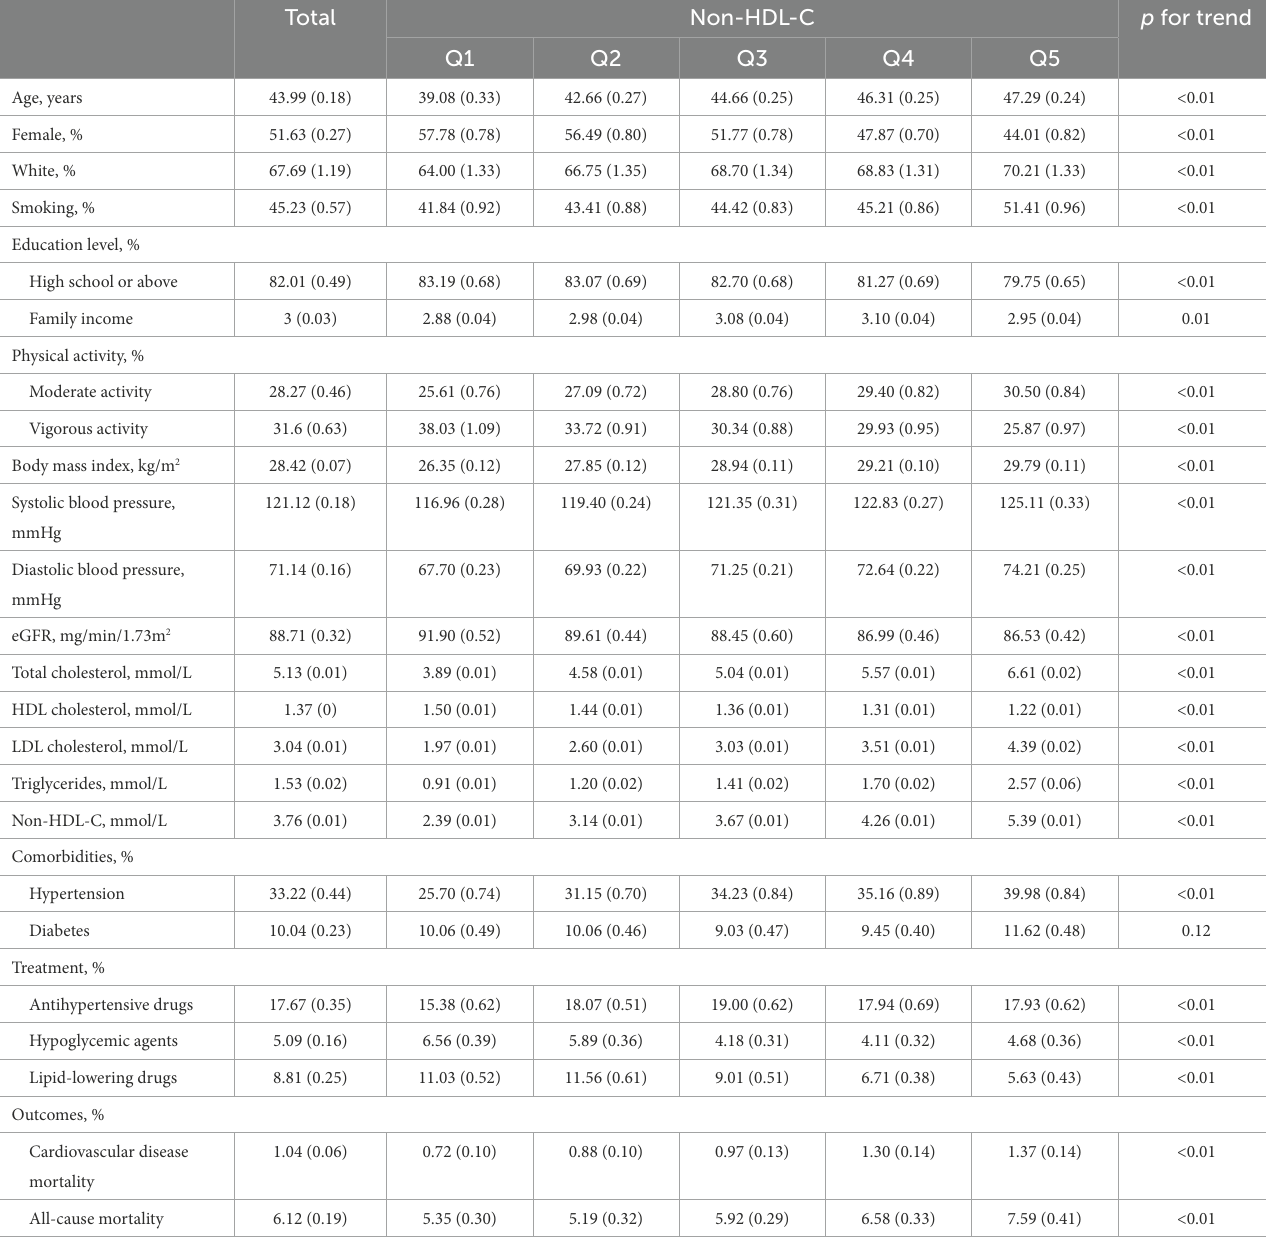
TABLE 1 Demographic and clinical characteristics according to non-HDL-C